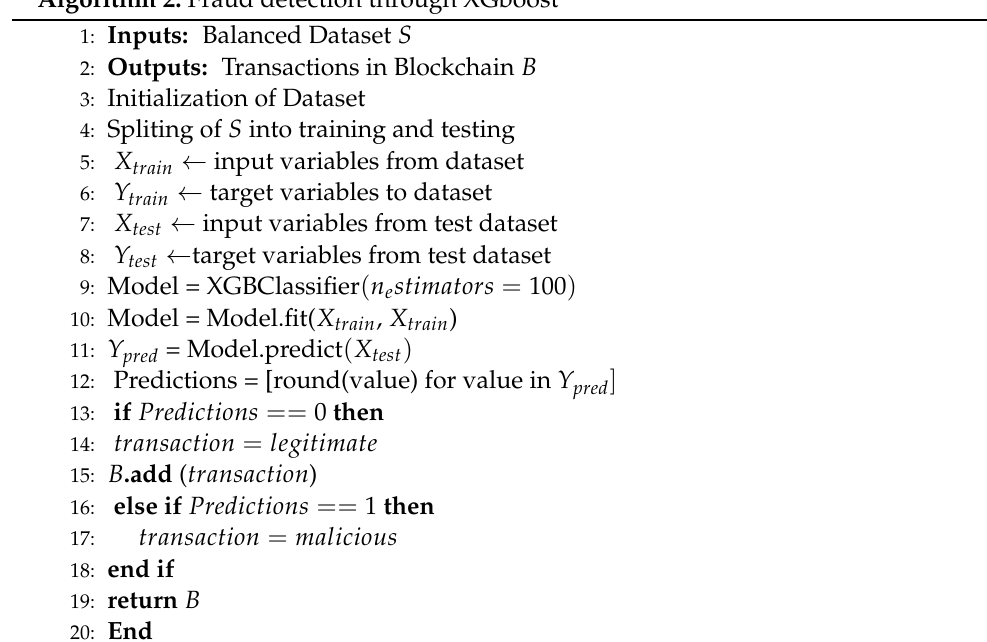
Algorithm 2: Fraud detection through